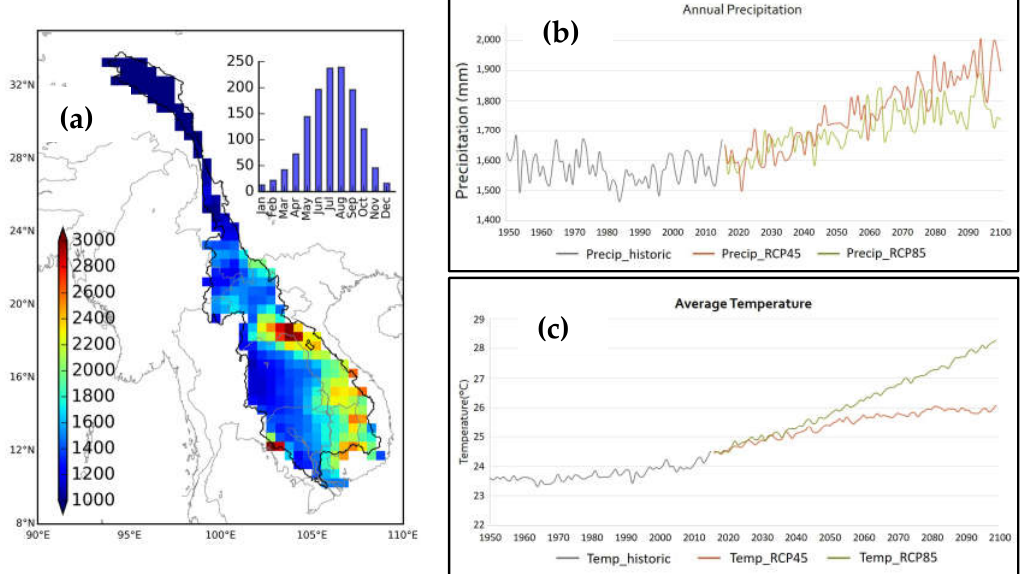
Figure 5. Long-term mean (1901–2010) annual precipitation (in mm/year) at 0.5° grids ( a ) along with the seasonal cycle (bar chart; in mm/month) obtained from the Global Precipitation Climatology Center (GPCC), and time series of basin-averaged annual total precipitation ( b ) and temperature ( c ) shown as mean of 10 CMIP5 GCMs for two different representative concentration pathways: RCP4.5 and RCP8.5.